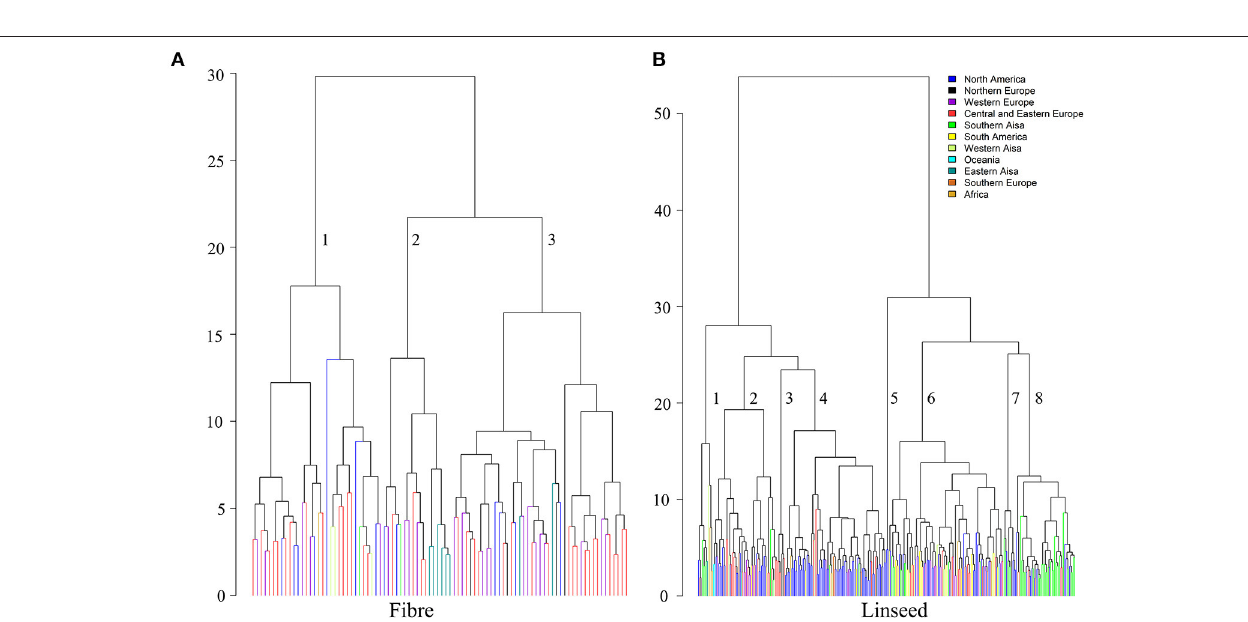
FIGURE 7 | Dendrograms derived from cluster analyses of the 92 fiber (A) and 299 linseed accessions (B) of the flax core collection. The Ward method was used for cluster analysis. Accessions are colored based on geographical